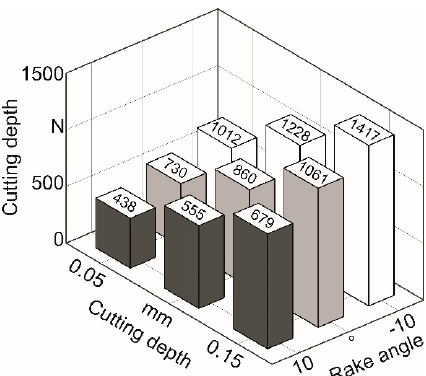
Figure 3. Plot of cutting force for different cutting depths and rake angles in the machining of Ti-1023 titanium alloy.